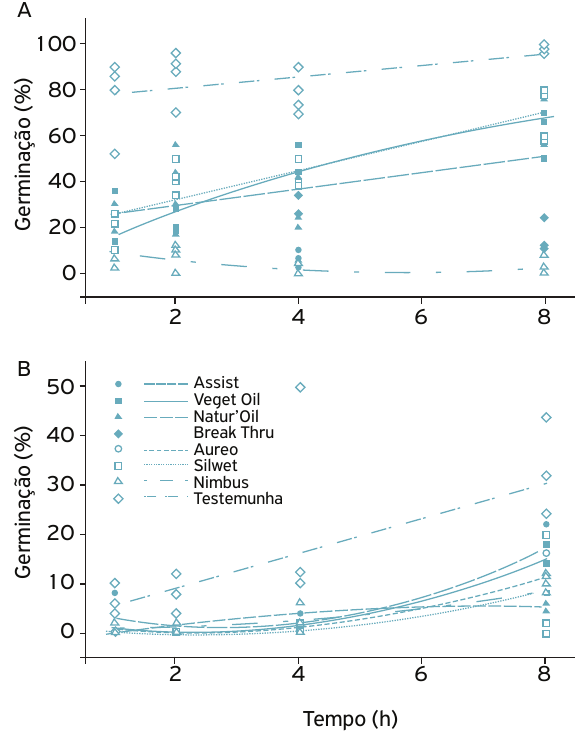
Figura 2. Germinação de Phakopsora pachyrhizi (A) e Puccinia kuehnii (B) em diferentes tempos de exposição a adjuvantes.